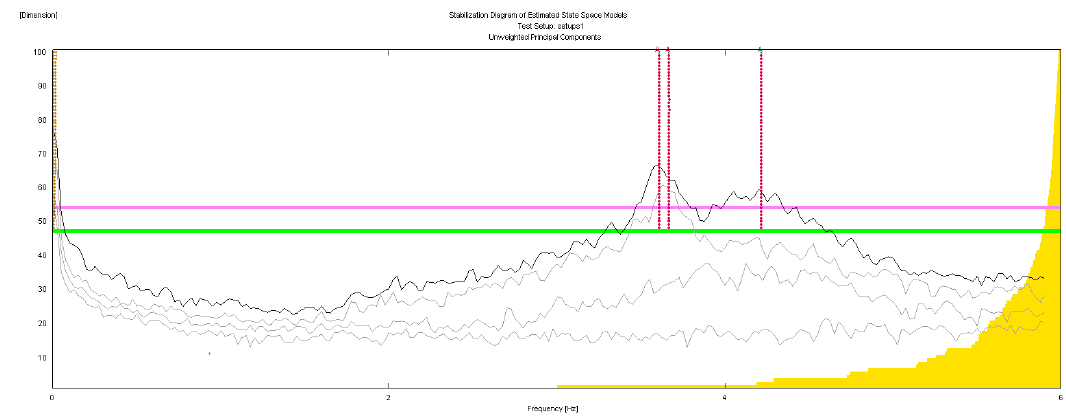
Figure 16. OMA identification with SSI method, Test 3.